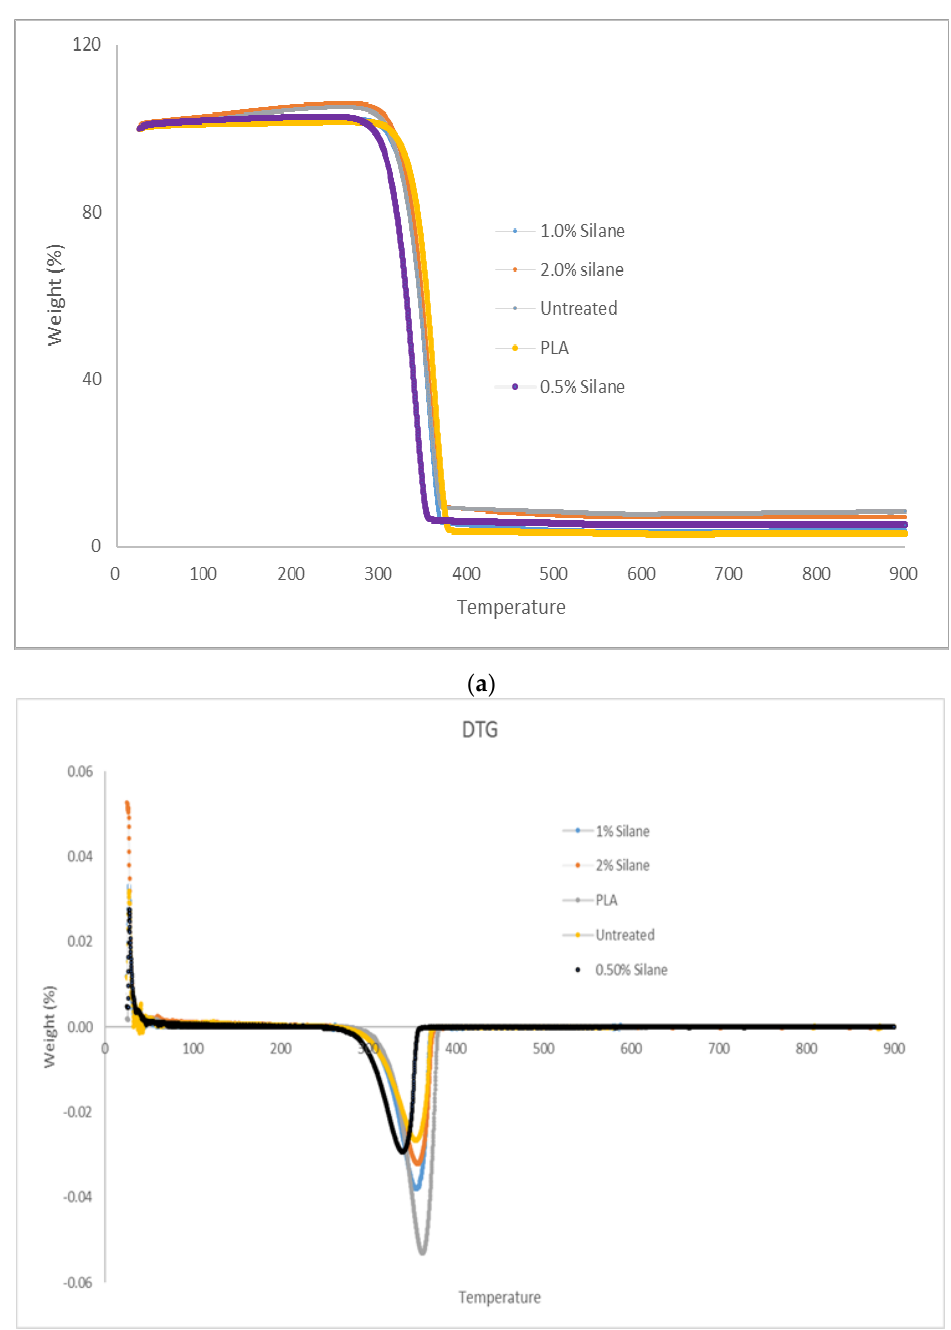
Figure 8. The results of composites ( a ) Thermogravimetric analysis (TGA); ( b ) Difference thermogravimetry (DTG).